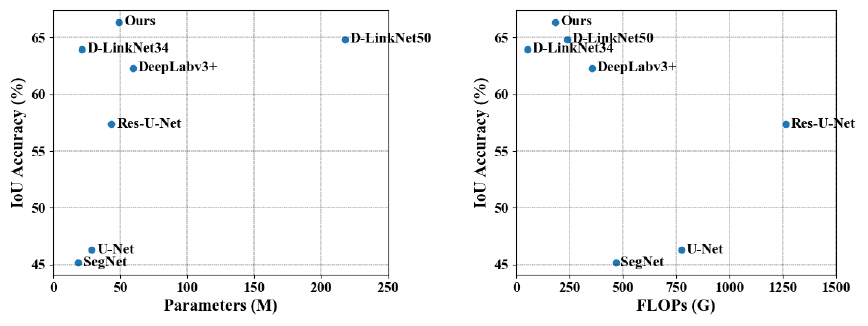
Figure 15. Comparison of accuracy vs. trainable parameters and FLOPs for related